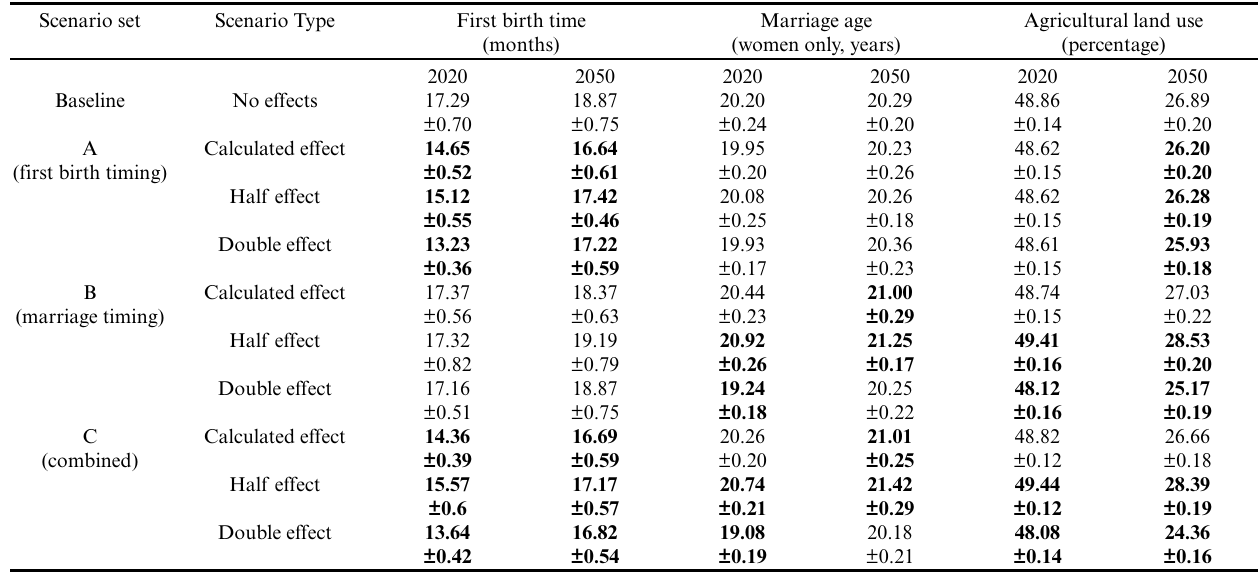
Table 6 . Final values of women’s mean first birth time, marriage age, and mean neighborhood percent agricultural vegetation for the year 2020 and the year 2050 for each of the 10 scenarios outlined in Table 5. Values are the mean values from 40 model runs of each scenario, ± 1.96 * the standard error of the mean. Values in bold vary significantly from the baseline